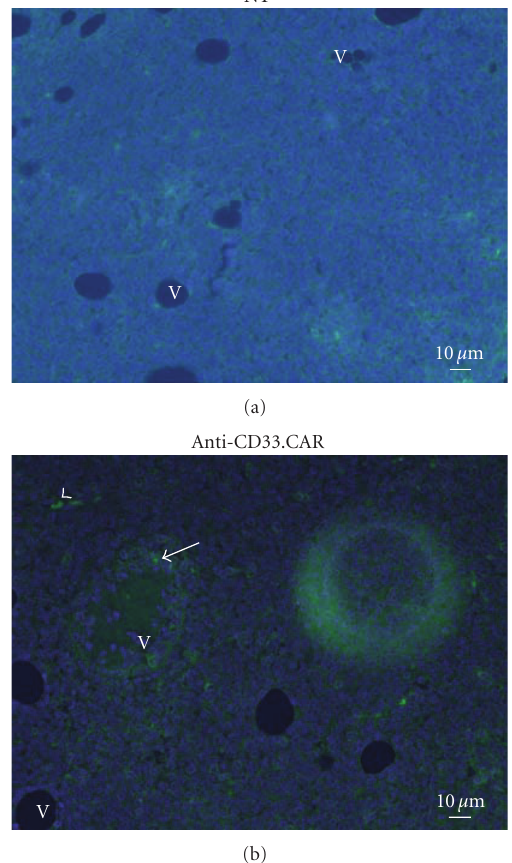
Figure 6: Infiltration of tumors by EBV-CTLs. Forty-eight hours after i.v. administration of EBV-CTLs, tumors were resected, fixed in 10% formalin solution, and embedded in para ffi n. CD8 + EBV- CTLs were detected by immunohistochemistry using an anti-CD8 antibody and reported in (a) unmodified EBV-CTLs, (b) CD33- EBV-CTLs. Genetically modified T cells were found at the periphery of the tumor in the vicinity of vessels (indicated as “V”), isolated or forming cluster (arrowheads or arrows,